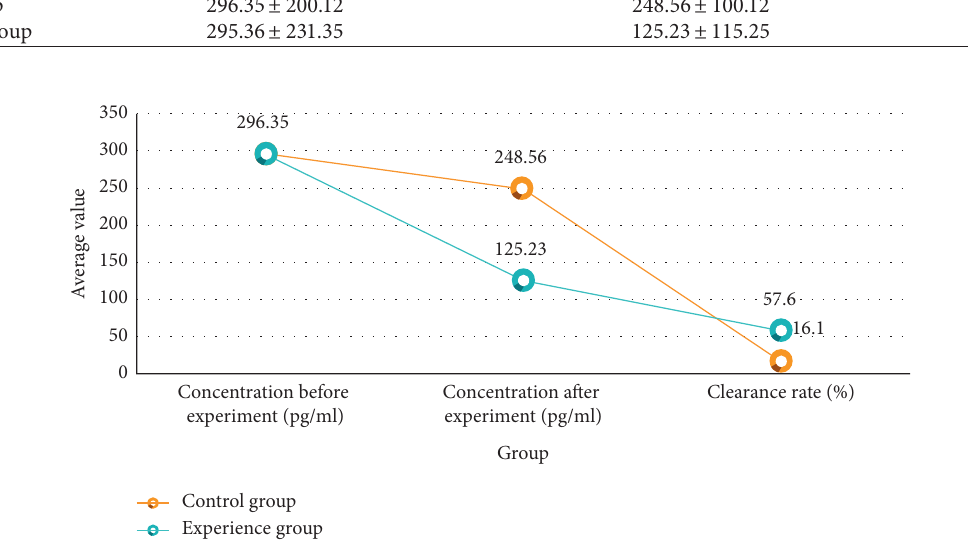
Figure 3: Analysis of the effect of removing middle molecular toxins. Table 2: Analysis of blood bun concentration before and after the two groups.